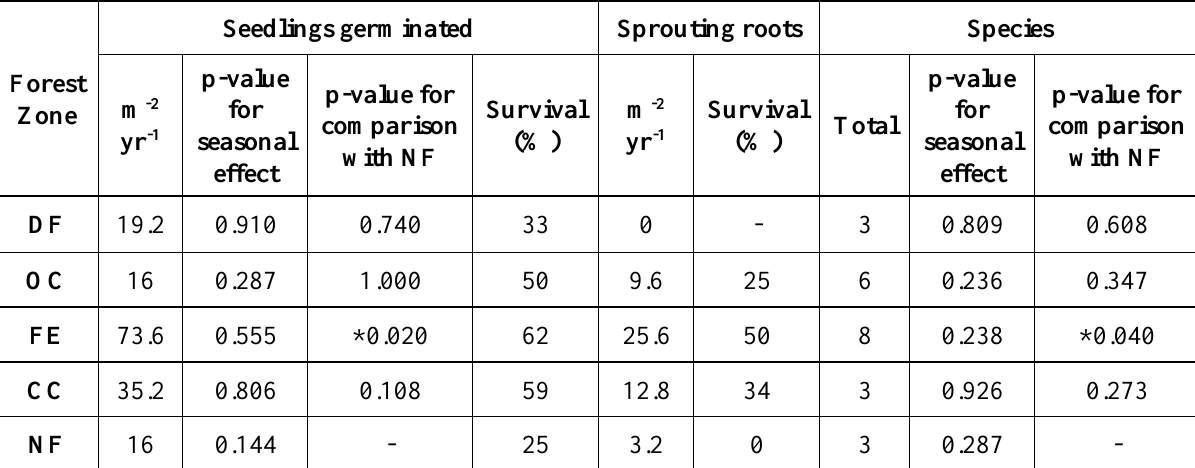
Table 3. Numbers of new plants that germinated from seeds and sprouted from roots, the average percentage survival of germinated seedlings and sprouting roots, and the annual total number of seedling and sprout species, for each FZ. Significance at the 0.05 level is denoted with an asterisk (*); see text for details of the statistical tests